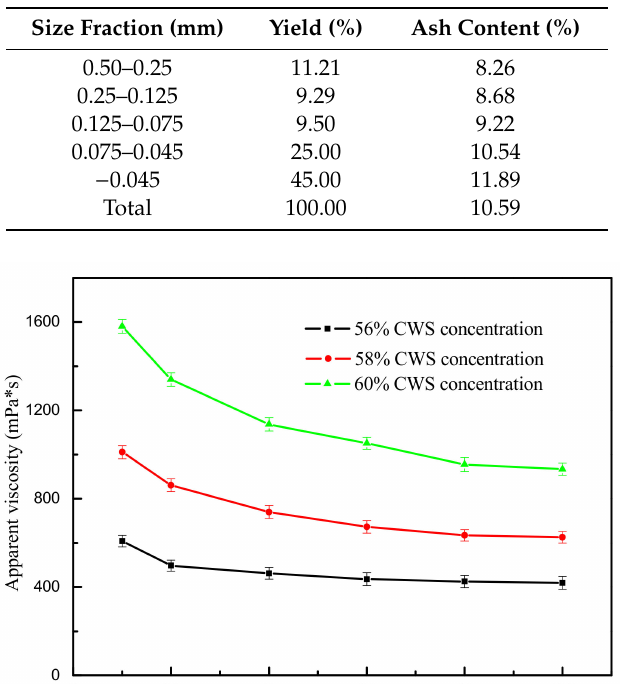
Table 5. Size distribution of the clean coal.